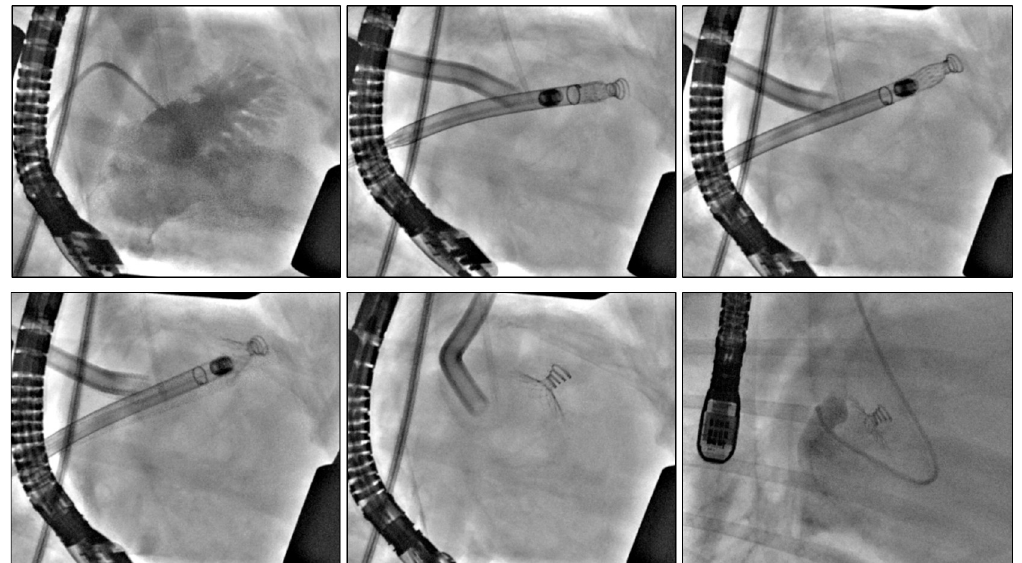
Fig 2. In vivo deployment of the StrokeShield device. Fluoroscopic images from 60-day chronic animal study showing in vivo deployment of the StrokeShield device. Panels A-E were obtained at baseline/implant and panel F at day-60 (terminal study). A, contrast dye injection into the LA showing the LAA. B, Direct surgical approach via the LA dome for placement of the StrokeShield device. The device is loaded on the tip of the delivery tool with partial exposure of the conical coil. C, StrokeShield device screwed into the LAA myocardium with delivery tool pullback in progress. D. Partial opening of the StrokeShield Nitinol umbrella. E. Complete opening of the StrokeShield Nitinol umbrella in place in the LAA ostium. F, StrokeShield device at day-60. Contrast dye injected via a ventriculogram catheter into the LA chamber shows no dye flow into the collapsed LAA. Panel F, originally obtained in right lateral decubitus position, has been flipped horizontally to match the left lateral decubitus position (right thoracotomy) of panels A-E.